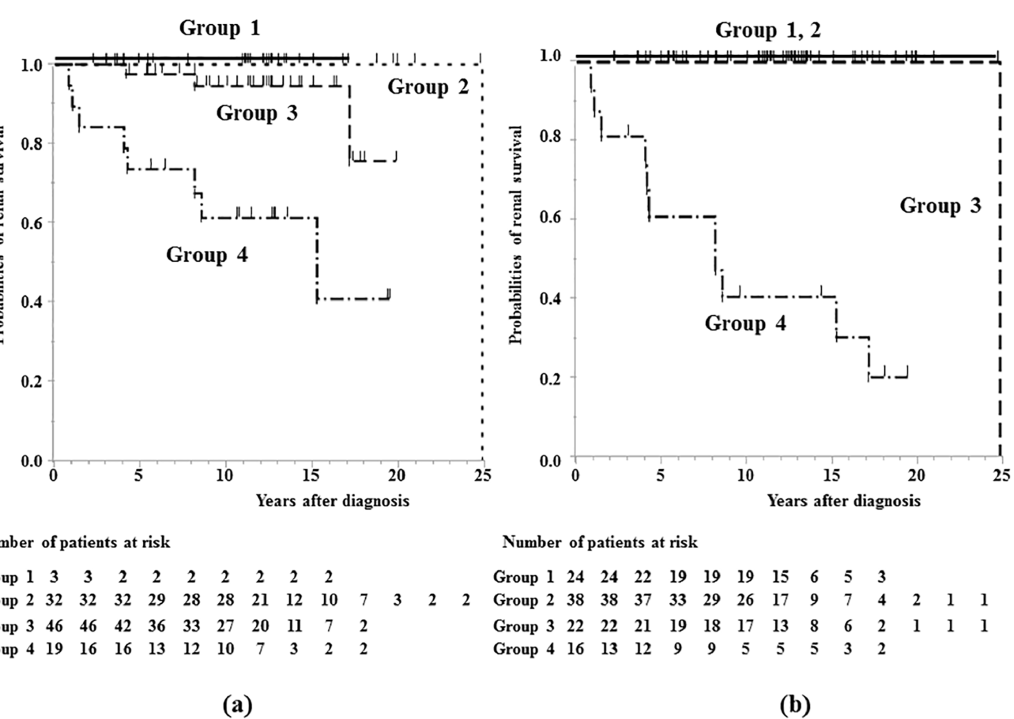
Fig 2. Survival curve showing time to ESKD. a) Kaplan-Meier plot showing time to ESKD stratified by proteinuria at diagnosis. b) Kaplan-Meier plot showing time to ESKD stratified by proteinuria during follow-up period. group 1, no proteinuria ( < 0.2 g/day/1.73 m 2 ); group 2, mild proteinuria (0.2 – 1.0 g/day/ 1.73 m 2 ); group 3, heavy proteinuria without hypoalbuminemia ( > 1.0 g/day/1.73 m 2 with serum albumin level (cid:1) 3.0 g/dL); group 4, heavy proteinuria with hypoalbuminemia ( > 1.0 g/day/1.73 m 2 with serum albumin level < 3.0 g/dL).